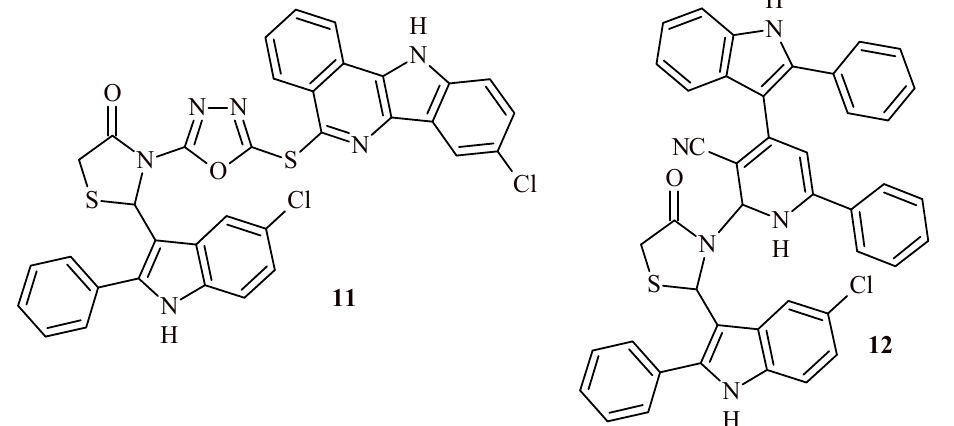
Figure 7. The structures of Compounds 11 and 12 .